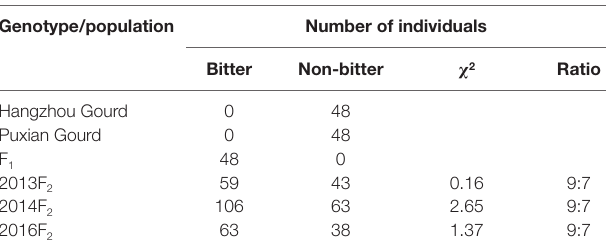
TaBle 1 | Fruit bitterness phenotypes.